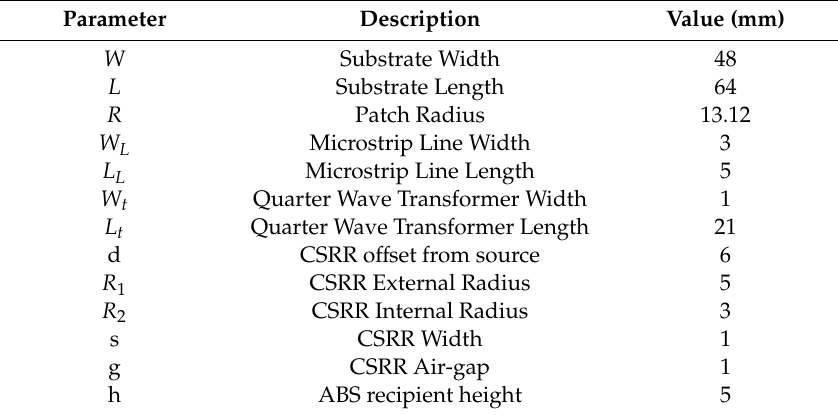
Figure 1. Proposed sensor: ( a ) Circular patch antenna; ( b ) double CSRR element; ( c ) sensor structure with the ABS 3D-printed container to hold the material under test (MUT). Table 1. Proposed sensor structural parameters.